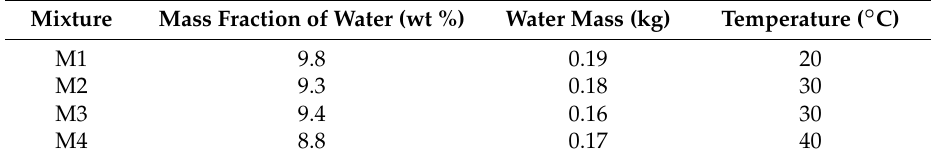
Table 1. Summary of initial operational conditions for acetone dehydration through the HybSi ® membrane.